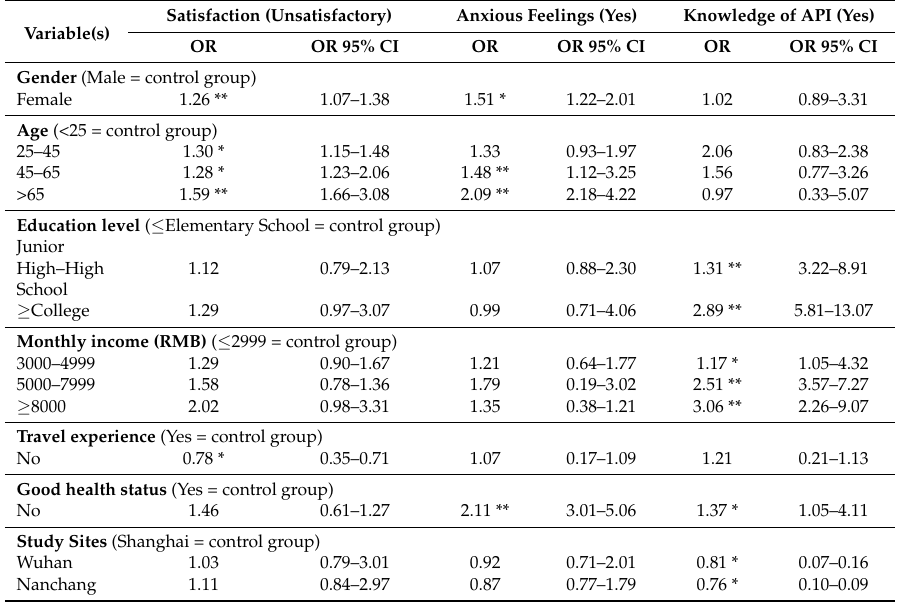
Table 3. Multivariable logistic regression analysis for the influencing factors among respondents’ satisfaction, anxious feelings and knowledge of API.